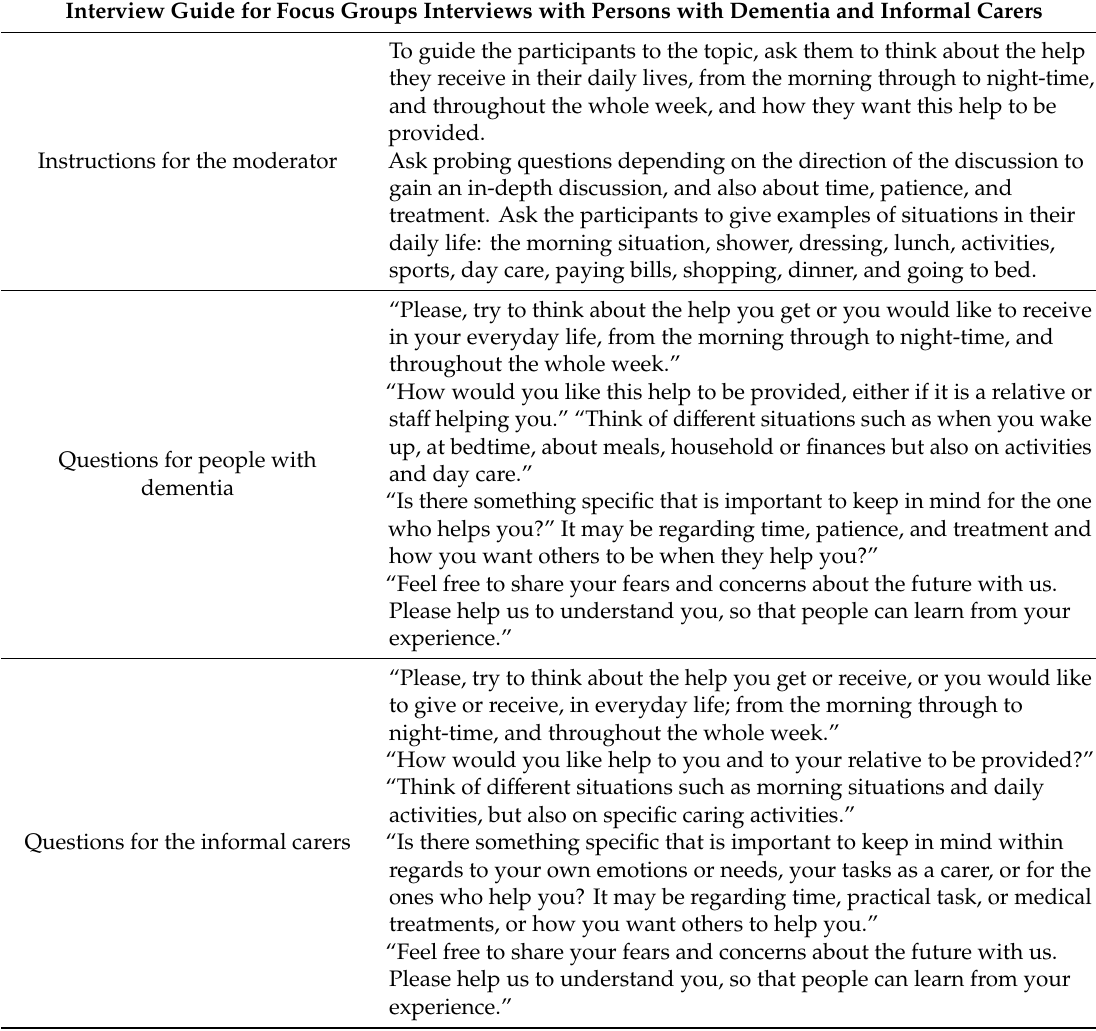
Table 2. Interview guide for the focus groups